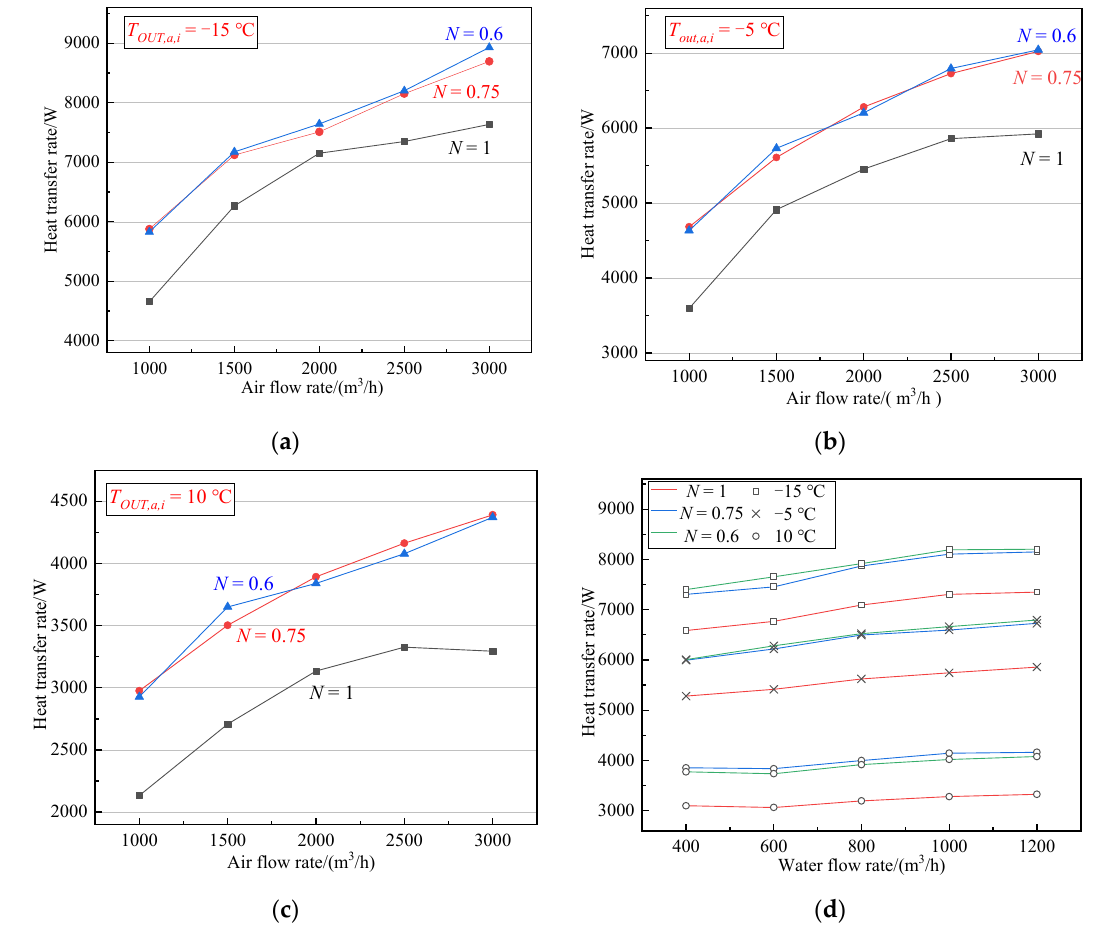
Figure 11. Heat transfer rate at different N and different air and water flow rates: ( a ) T OUT , a , i = − 15 °C;